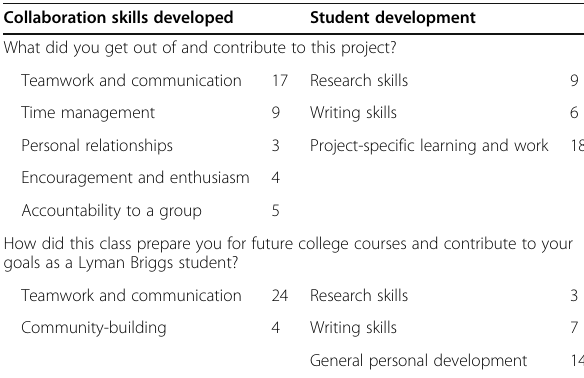
Table 3 Short-answer questions that the students answered